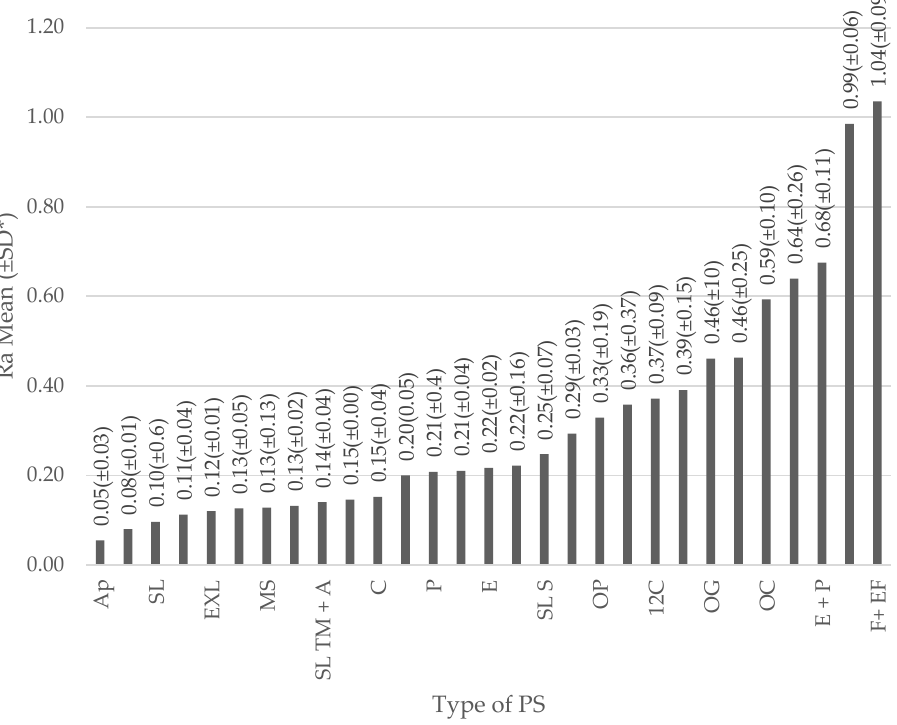
Figure 3. Surface roughness according to the polishing system (PS). Note: The figure represents, on the X axis, the PS and, on the Y axis, the surface roughness reached in Ra µm. The height of each bar represents the mean Ra (±SD) obtained for each PS. * SD = Standard Deviation. List of abbreviations for type of PS: Ap (Astropol), SSR (Super-snap Rainbow Tech- nique Kit [Shofu]), SL (Sof-Lex Discs [4 SPS]), SL TM (Sof-LexTM Pop-On + felt disc associated to diamond paste [Diamond